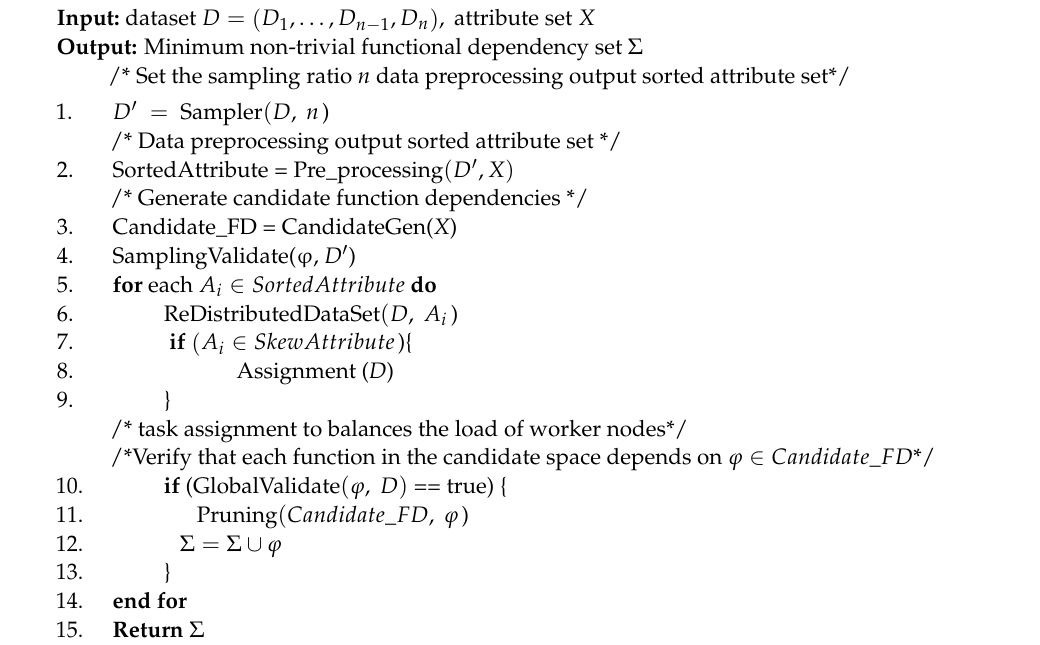
Algorithm 1 . Distributed Functional Dependency Discovery Algorithm